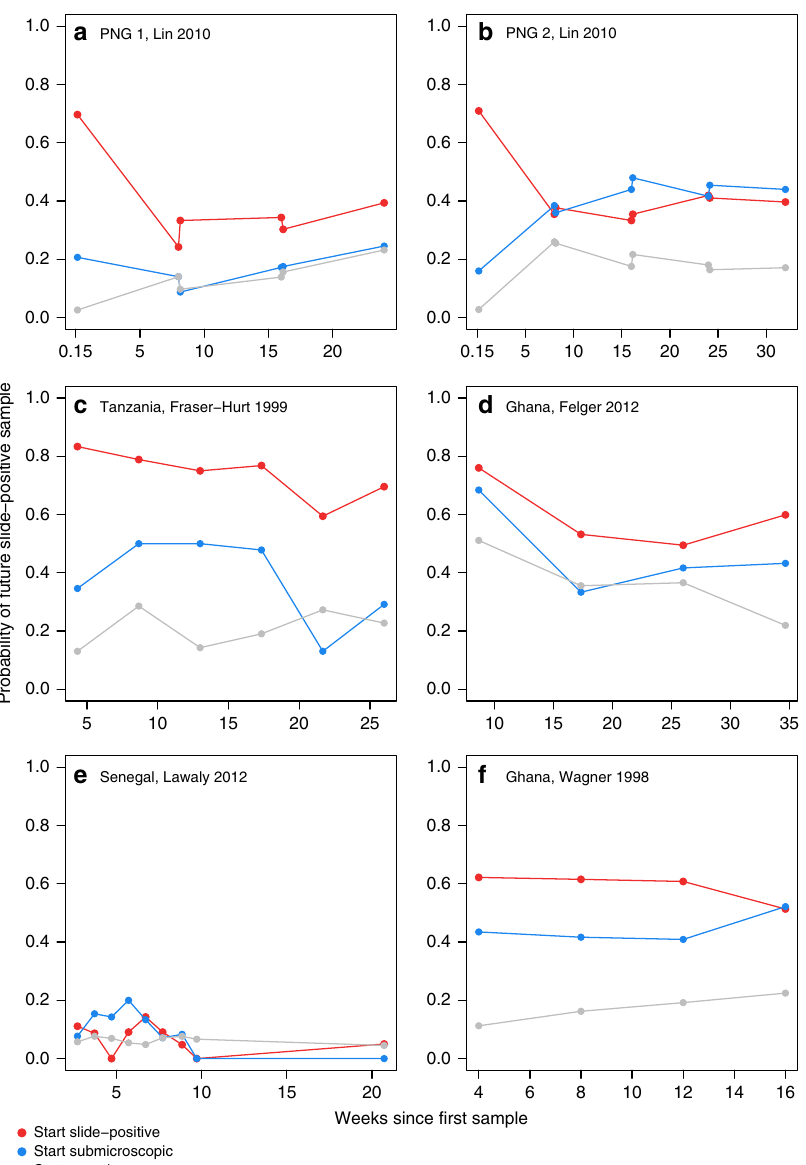
Fig. 5 The probability of being slide-positive after the current sample, by initial infection status. Data are shown for the cohorts listed in Table 1 which had available data. Country, fi rst author and year of publication are indicated. We excluded cohorts in which no individuals experienced submicroscopic infection. The Papua New Guinea (PNG) cohort was divided into two because of its long duration, and to show that the choice of start point can be important (PNG 1 started May 2006 and PNG 2 started November 2006). The PNG cohort had a fi rst follow-up time on day 1 and afterwards was followed up on consecutive days every 8 weeks (top 2 panels). Source data are provided as a Source Data fi